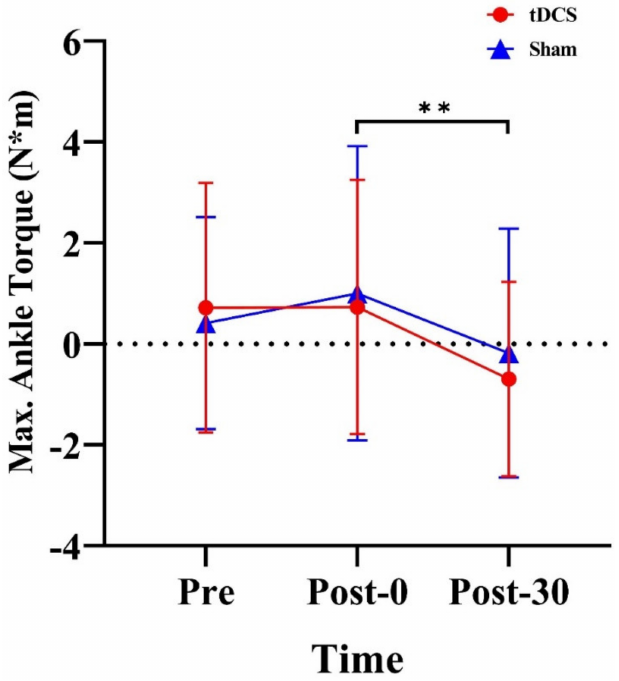
Figure 7. Effects of tDCS on maximum ankle torque in CMJs. ** indicates a significant main effect of time. Max., maximum. Pre: pre-stimulation, Post-0: post-0 min, Post-30: post-30 min.